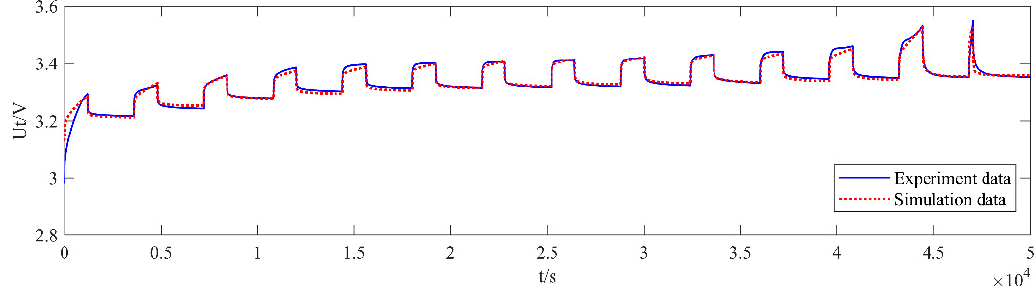
Figure 4. Comparison of 5 A variable current charging experiment results and battery model simulation results.